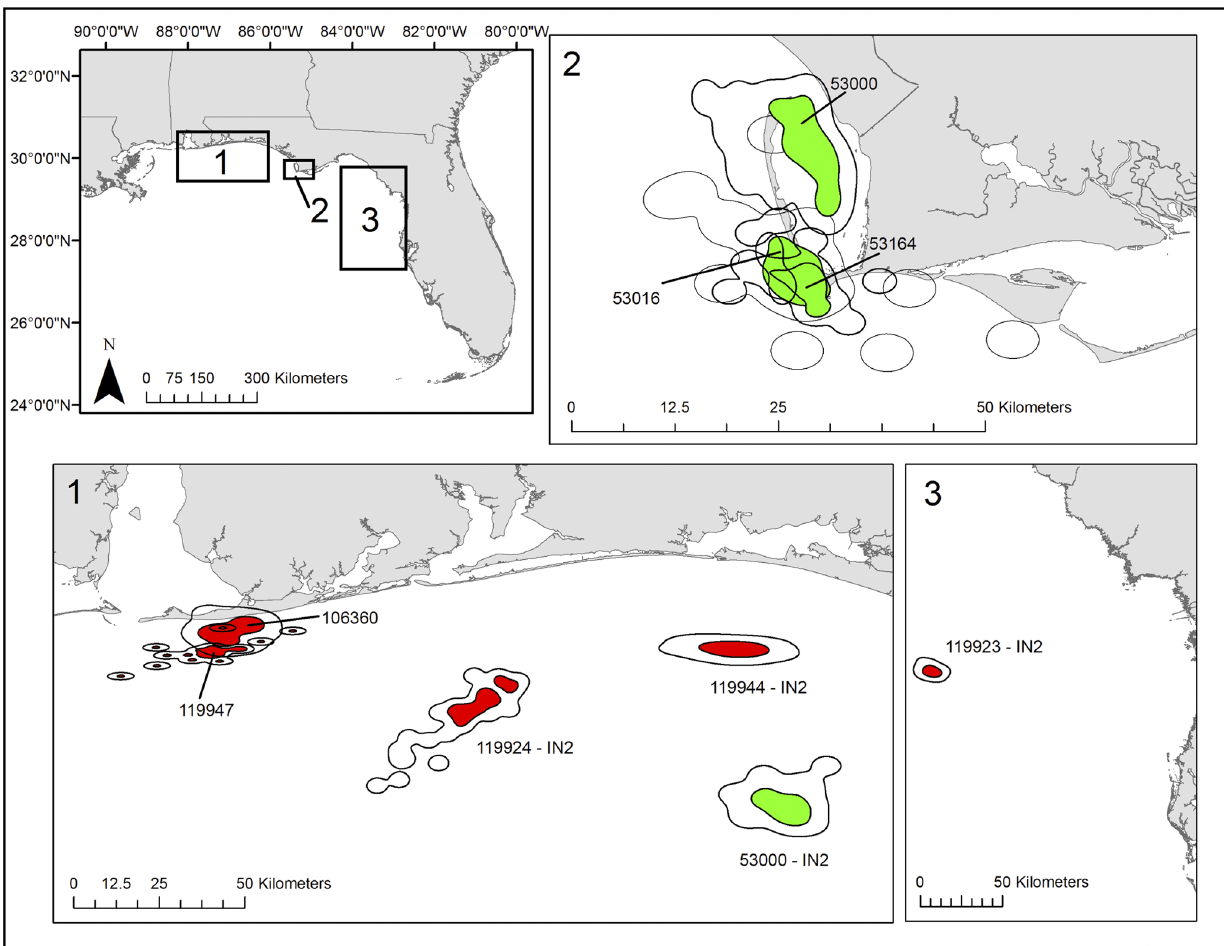
Figure 3. Plot of inter-nesting 95% (outer line) and 50% (shaded in) kernel density estimates (KDE) for adult Northern Gulf loggerheads ( Carettacaretta ) during inter-nesting. Red indicates turtles that were tagged at the AL study site and green indicates turtles tagged at the SJP study site.